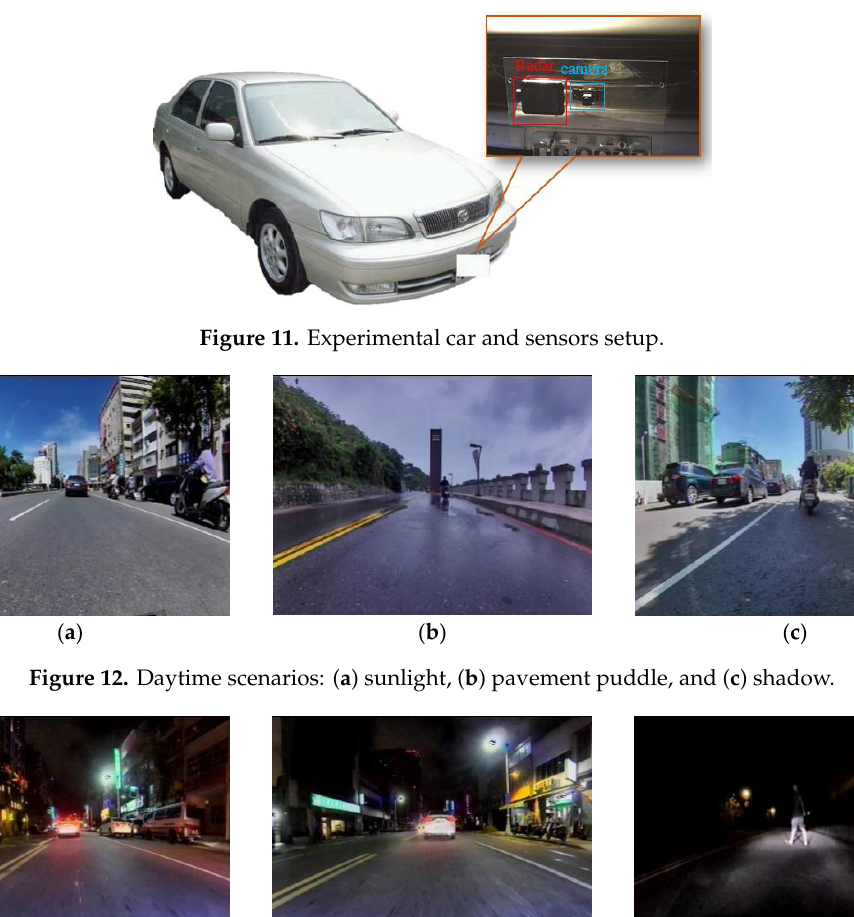
Figure 12. Daytime scenarios: ( a ) sunlight, ( b ) pavement puddle, and ( c ) shadow. Figure 13. Nighttime scenarios: ( a ) brake light, ( b ) headlight reflection, and ( c ) poor lighting.